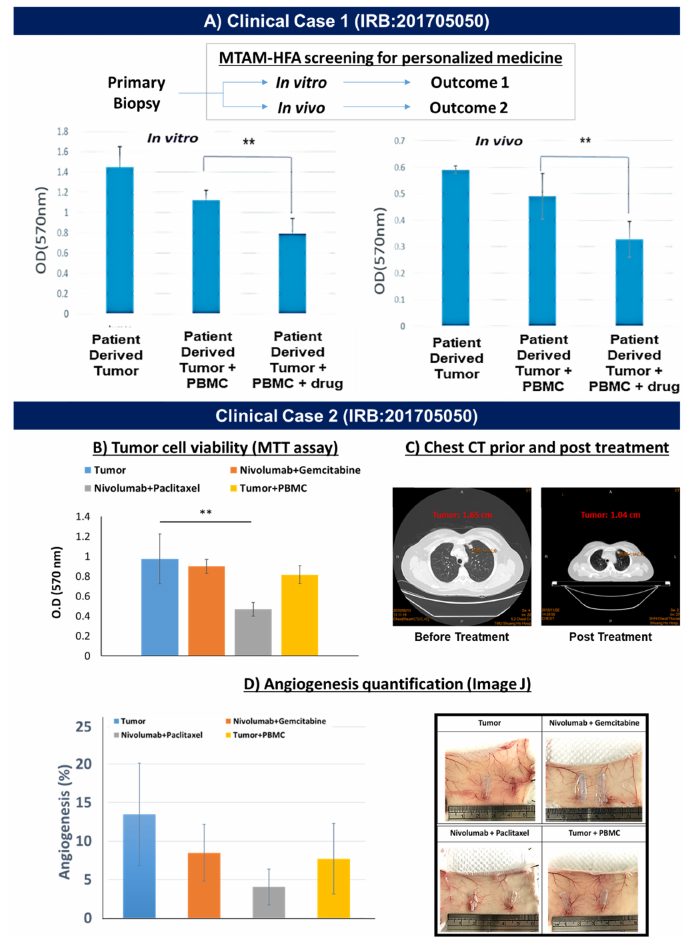
Figure 4. ( A ) Feasibility testing of the MTAM-HFA utilizing primary lung cancer cells which revealed a similar trend between the in vitro and in vivo groups. ( B ) Actual testing of the MTAM-HFA in personalized medicine for the personalized medicine application, successfully demonstrated correlation to the MTAM-HFA screening outcome (** equivalent to p- value < 0.01); ( C ) The resulting clinical outcome after the corresponding patient was administered the respective therapy which revealed a significant improvement in clinical outcome; ( D ) The angiogenesis assessment of the subcutaneous region of the balb/c mice utilized in the MTAM-HFA anti-cancer drug screening, which revealed a similar trend between the degree of angiogenesis and the viability of the primary lung cancer cells found in ( B ).